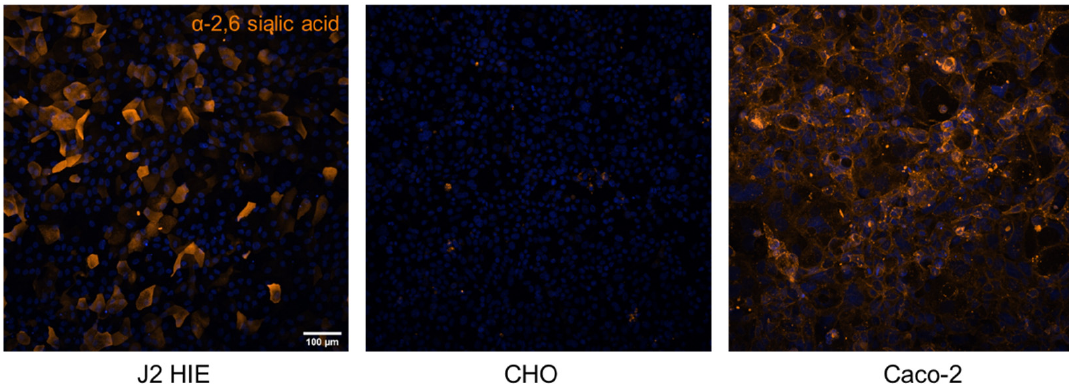
Figure 5. Jejunal HIE line J2 expressed α 2,6-sialic acid glycans. Previously unpublished images. Monolayers of J2 (left), Chinese hamster ovary cells (CHO; middle), and Caco-2 cells (right) were fixed, permeabilized, and stained with Cy3 labeled Sambucus nigra lectin (orange), following protocols previously used for UEA-1 staining [48]. Caco-2 cells, that express α 2,6-sialic acids, and CHO cells, that do not express α 2,6-sialic acids, were included as positive and negative controls, respectively.